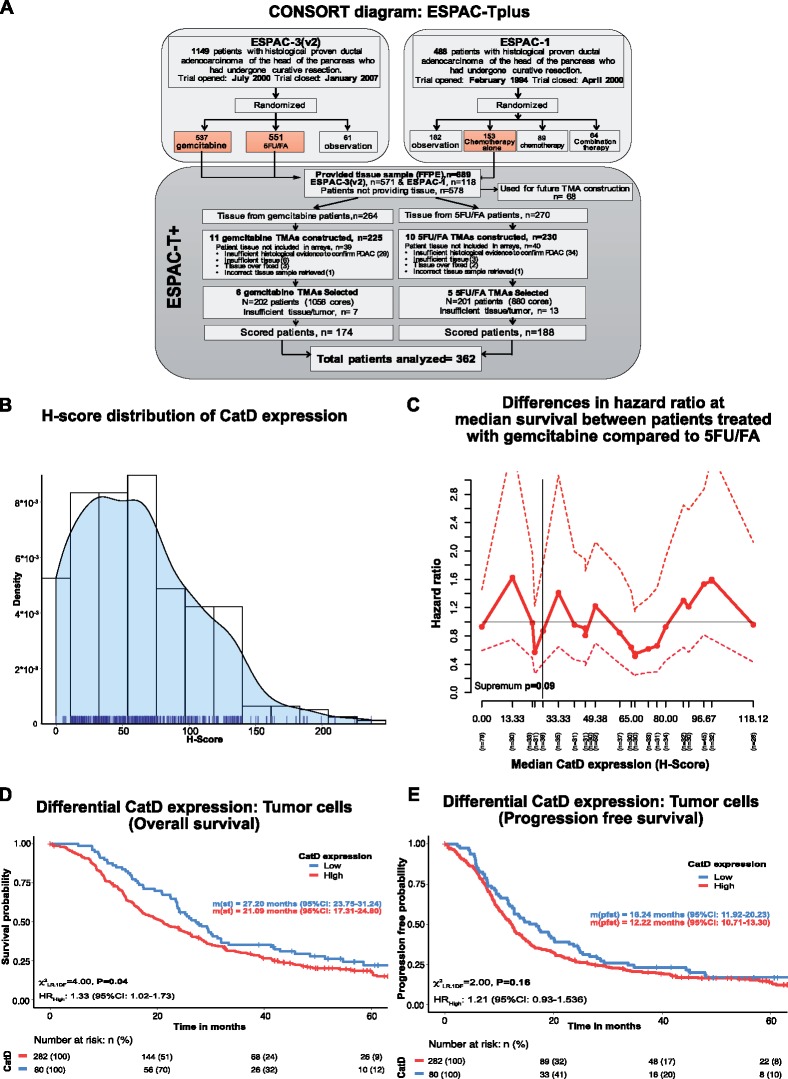
Association of CatD expression with overall survival and progression-free survival in resected PDAC patients (ESPAC cohort). A) CONSORT diagram. B) Relative frequency distribution and rug plot of CatD H-score in 362 patients. C) The plot shows the actual differences in risk at median survival in various CatD expression subgroups between the 5FU/FA- and gemcitabine-treatment groups (solid line) with a 95% CI (dashed lines). Solid red horizontal line indicates overall treatment effect, and dotted vertical lines indicate the cutoff for the dichotomization. P values are from interaction test with bootstrapping. D) Survival curves dichotomized by CatD expression levels (high = median H score > 22.35; low = mean H score ≤ 22.35). E) Progression-free survival dichotomized by CatD expression levels. All groups and the number of at-risk individuals are shown at the bottom of graph. All statistical tests were log-rank analyses using two-sided χ2 tests. P < .05 considered statistically significant. 5FU/FA = 5-fluorouracil-folinic acid; CatD = cathepsin D; CI = confidence level; CONSORT = Consolidated Standards of Reporting Trials; ESPAC = European Study Group for Pancreatic Cancer; FFPE = formalin-fixed paraffin-embedded; m(st) = median survival time; m(pfst) = median progression-free survival time; PDAC = pancreatic ductal adenocarcinoma; TMA = tissue microarray.